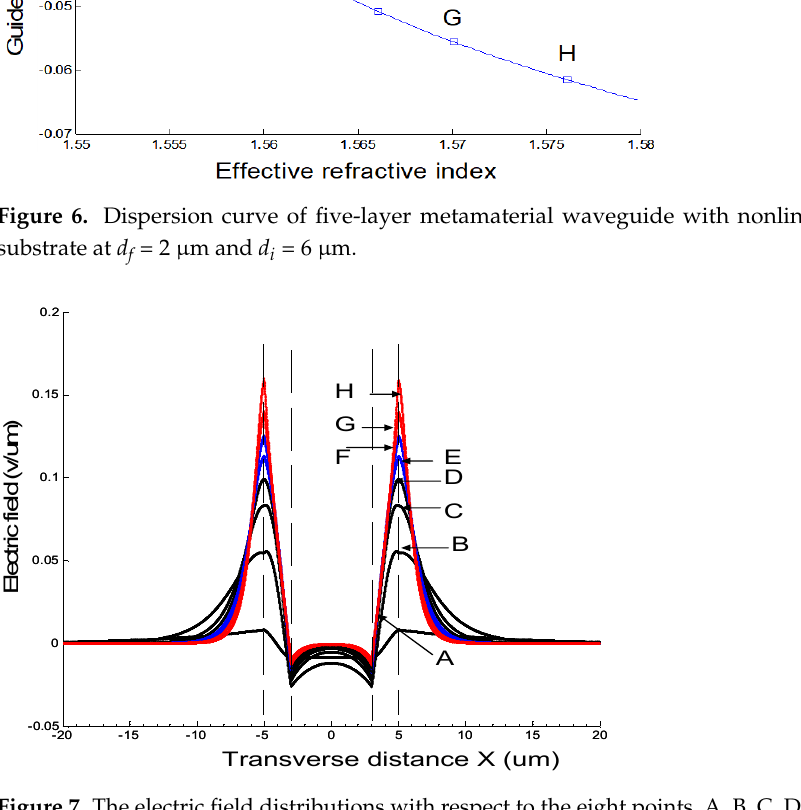
Figure 8. Figure 8. Dispersion curve of five-layer metamaterial waveguide with nonlinear cladding and substrate at d f = 5 μ m and d i = 6 μ m.